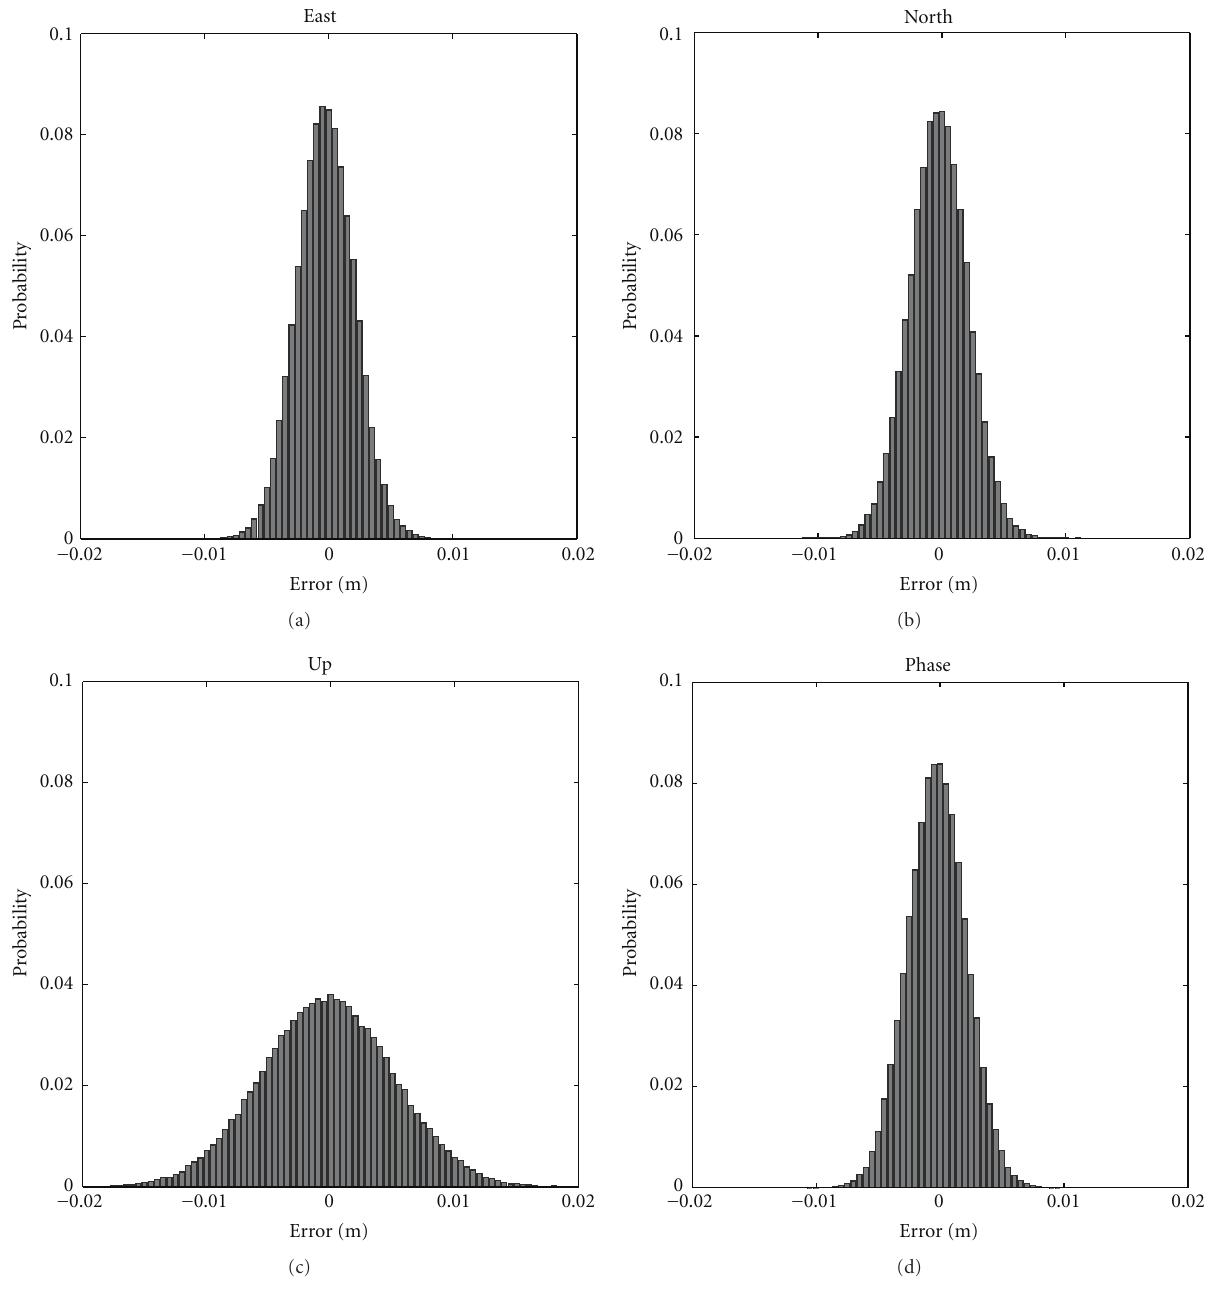
Figure 4: Histograms of the errors in the east, north, and up directions and the constant phase o ff set. The phase o ff set is expressed in units of meters to enable comparison with the other